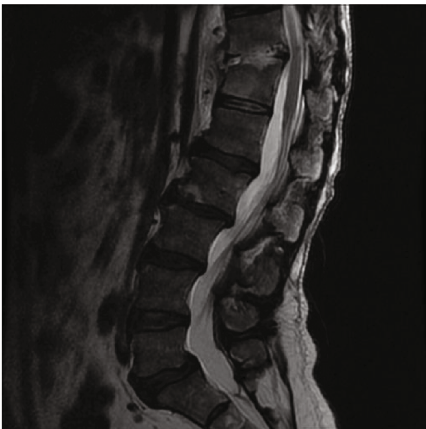
Figure 1: MR thoracic spine T2-weighted image demonstrates mild enhancement in the T11-T12 disc space with mild endplate erosion. No signi fi cant spinal stenosis.